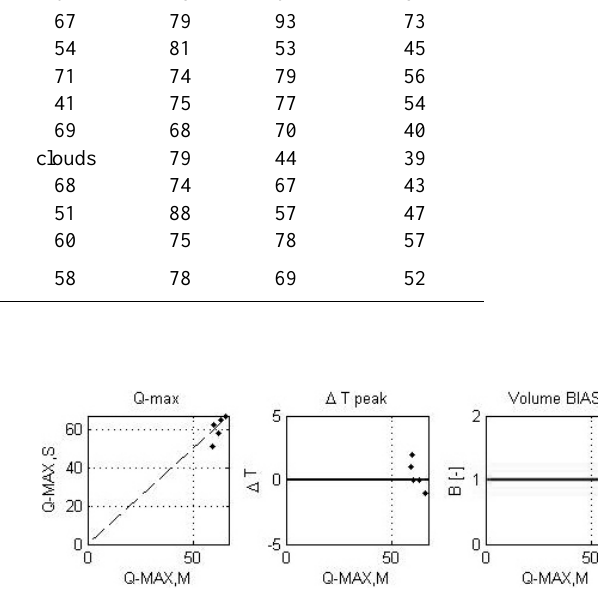
Fig. 5. Model efficiencies for validation peak flows separated on the basis of the one-year recurrence interval at the Vent – Venterache gauge (165km 2 ). Left: measured peak flow ( Q MAX , M [m 3 /s]) vs. simulated peak flow ( Q MAX , S [m 3 /s]); middle: temporal shift of the peak flow ( 1T [h]) vs. ( Q MAX , M [m 3 /s]); right: bias of the events discharge volume ( B [-]) vs. ( Q MAX , M [m 3 /s]).